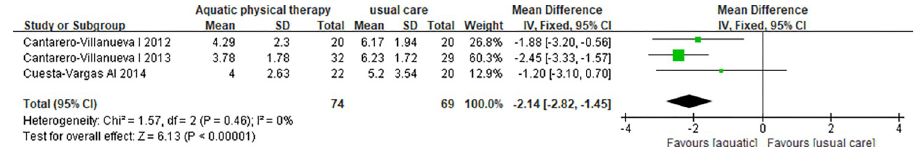
Fig 4. Meta-analysis of studies assessing fatigue between aquatic physical therapy and usual